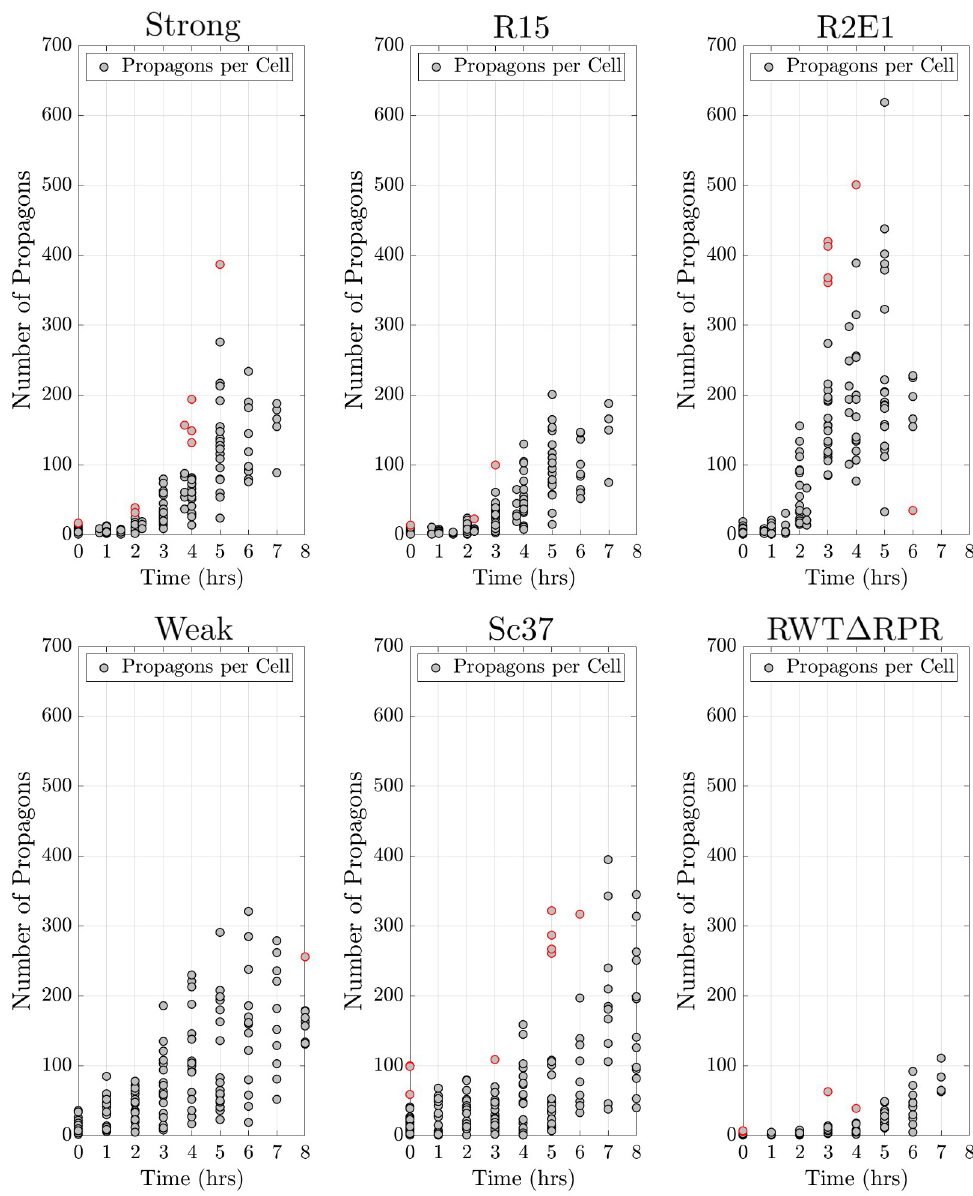
Fig 4. Experimental propagon counts for six prion variants. This experimental data was obtained through propagon recovery experiments (see the biological background section for more details). Data points outlined in red were determined to be outliers by the IQR